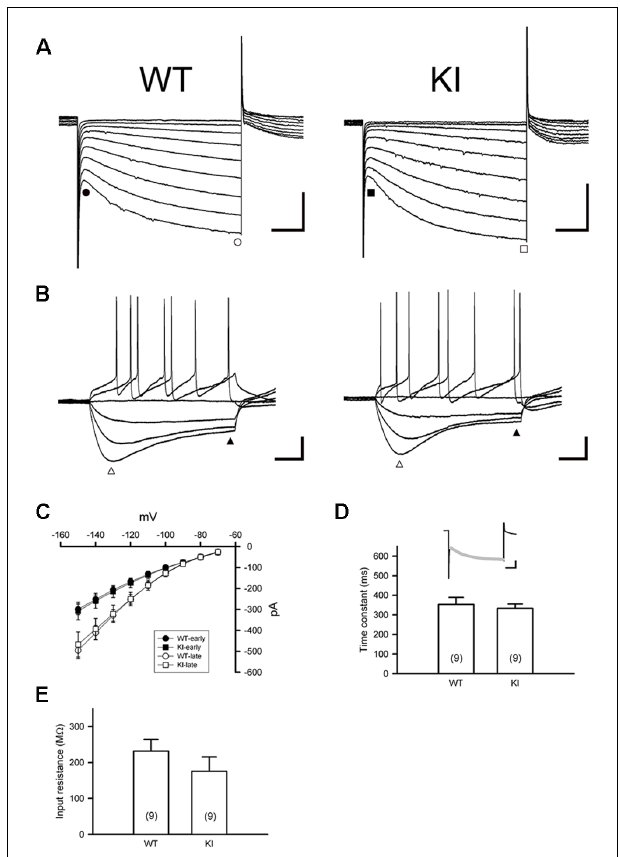
FIGURE 2 | Characterization of I h current in substantia nigra DA neurons in the WT and Ddc KI (KI) mice. (A) Currents were evoked in individual DA neurons by stepping from a holding potential of − 60 mV to membrane potentials ranging from − 70 to − 150 mV in 10 mV decrements. Scale bars: 200 pA and 200 ms. (B) Responses of membrane potential to injection of hyperpolarizing currents ( − 90 to +60 pA in steps of 25 pA). A prominent inward rectification “sag” occurs during negative current injection (open triangle). Scale bars: 20 mV and 200 ms. (C) The current–voltage (I–V) relationships of WT ( n = 12 cells) and KI mice ( n = 14 cells). Currents were measured at instantaneous (WT, filled circle; KI, filled square) and steady-state (WT: open circle; KI: open square) during the voltage steps in (A) . (D) Time constant of activation of I h as determined by fitting the activating phase of the current trace with a single exponential function (insert, gray line). Scale bars: 200 pA and 200 ms). No differences were observed between WT and KI mice ( n = 9 cells for each group). (E) Summary bar graph showing the input resistance in WT and KI mice ( n = 9 cells for each group). Input resistance was calculated from the linear range ( − 90 to − 30 pA) of I–V relationships determined at the end of voltage traces (filled triangle) in ( B ; n = 4–5 in each